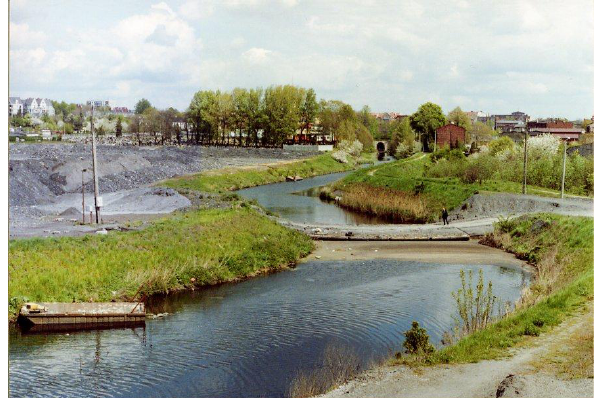
Fig. 1. The mouth of drainage adit “Kościuszko” in Tarnowskie Góry ( M. Lamparska-Stobiecka )